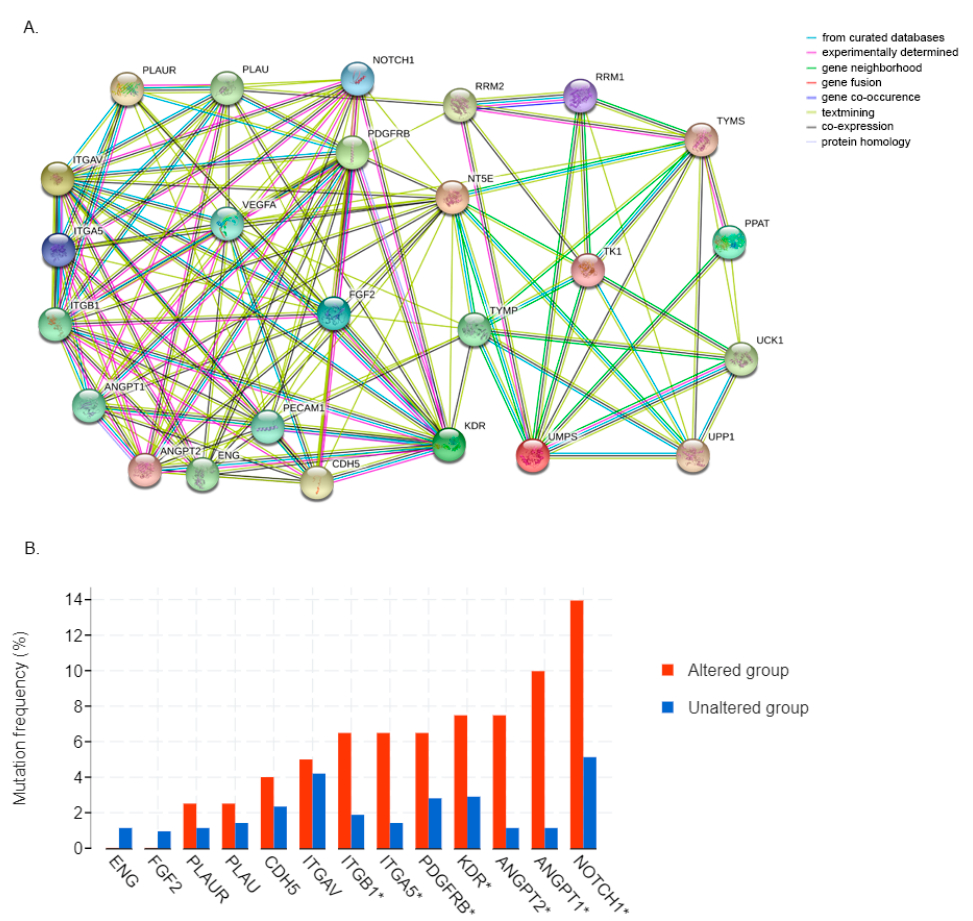
Figure 7. ( A ) A comprehensive map of the known and predicted interactions between 5FU converting system enzymes and several important proteins involved in tumor and physiological